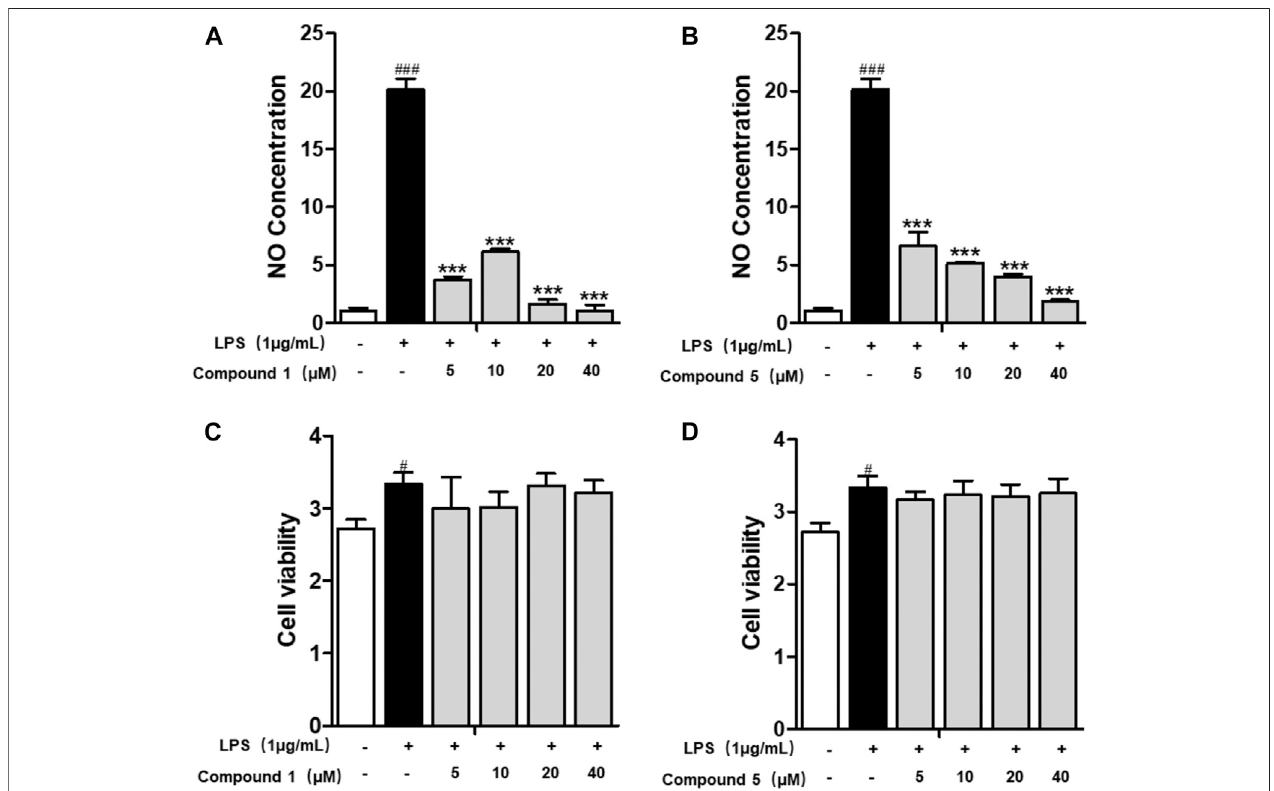
FIGURE6| Compounds 1 and 5 exertsigni fi cantanti-in fl ammatoryeffectonRAW264.7 macrophage cells.Effects of 1 and 5 ontheNOproduction (A,B) and cell viability (C, D) of LPS-induced RAW264.7. Cells were treated with various concentrations of 1 and 5 ranging from 5, 10, 20, and 40 μ M. Data were presented as the mean ± SEM ( n (cid:2) 4). # p < 0.05, ### p < 0.001 vs. control, *** p < 0.001 vs. model.